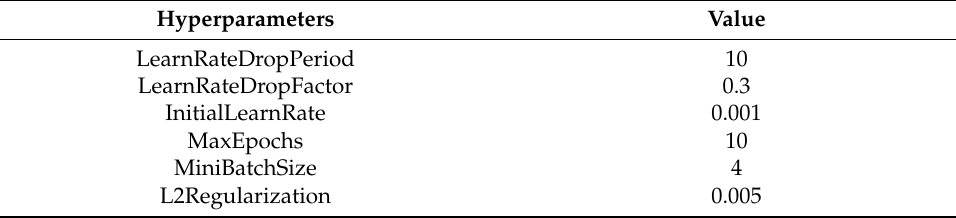
Table 2. Fixed hyperparameters and values for ASA-DRNet.